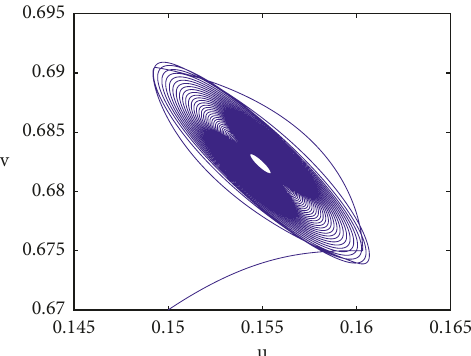
Figure 9: Phase diagram of system (9) at E ∗ ( u ∗ , v ∗ ) � ( 0 . 1549 , 0 . 6823 ) when D